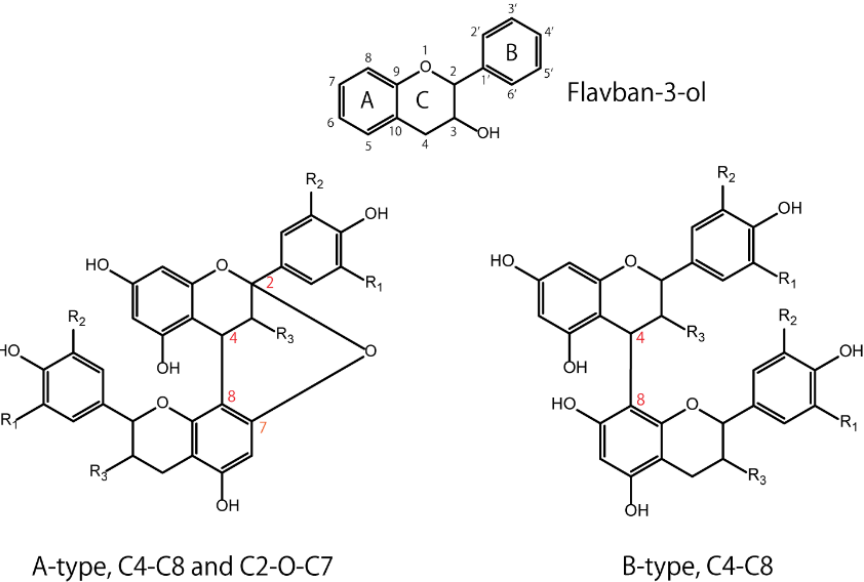
Figure 1. Basic structures of flavan-3-ol: A-type and B-type proanthocyanidins. Regarding the DP and stereochemistry of oligomeric PACs, the condensation of monomeric flavan-3-ol units compactly forms a helical PAC structure in an aqueous solu- tion [30–32], leading to interactions between saliva proteins, which causes astringency in wine-tasting processes [33]. In addition, the hydrophobicity of PACs, as measured with